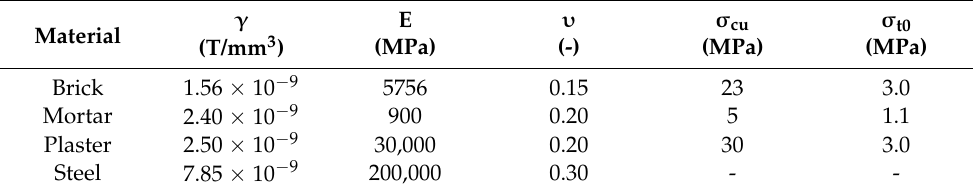
Table 1. Mechanical properties for brick, mortar, plaster, and